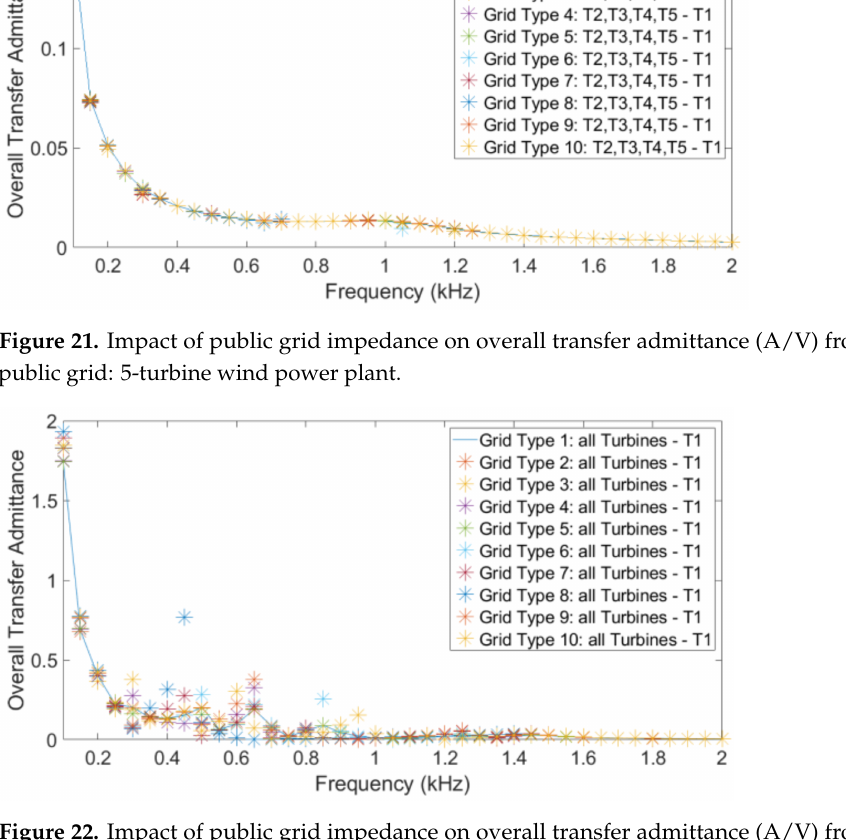
Figure 22. Impact of public grid impedance on overall transfer admittance (A/V) from turbine to public grid: 42-turbine wind power